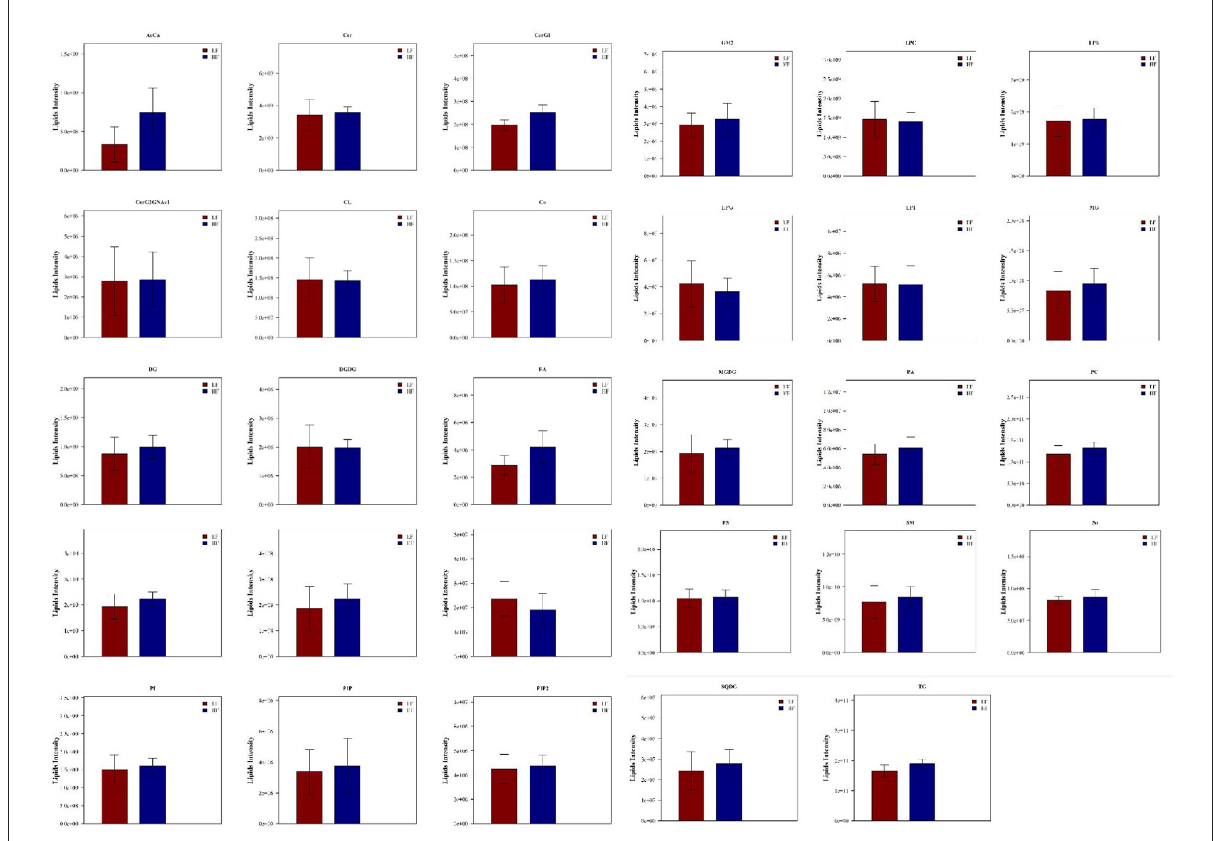
FIGURE4 Relative abundance of lipid subclasses between HF and LF